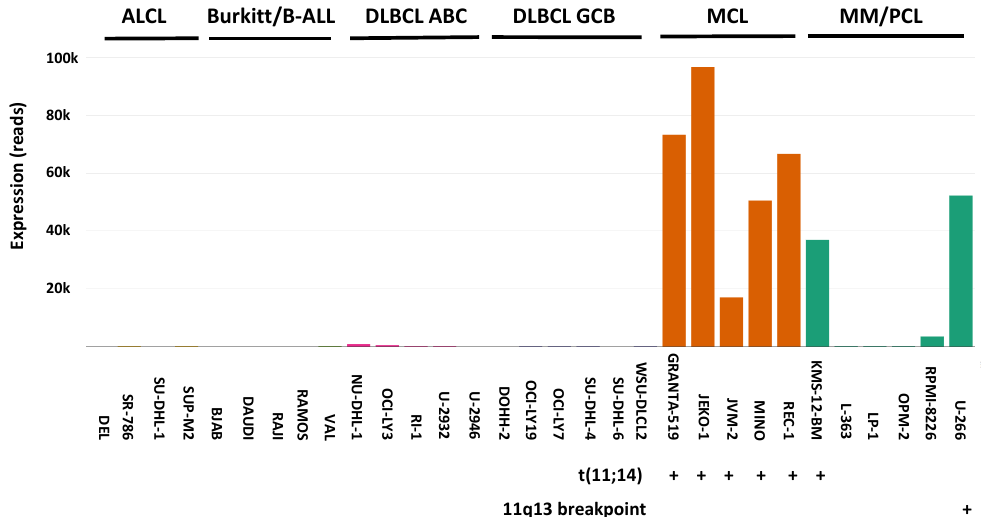
Figure 4. Example of gene overexpression. Here using RNA-sequencing we examined overexpression of CCDN1 in cell lines derived from various lymphoma subgroups: anaplastic large cell